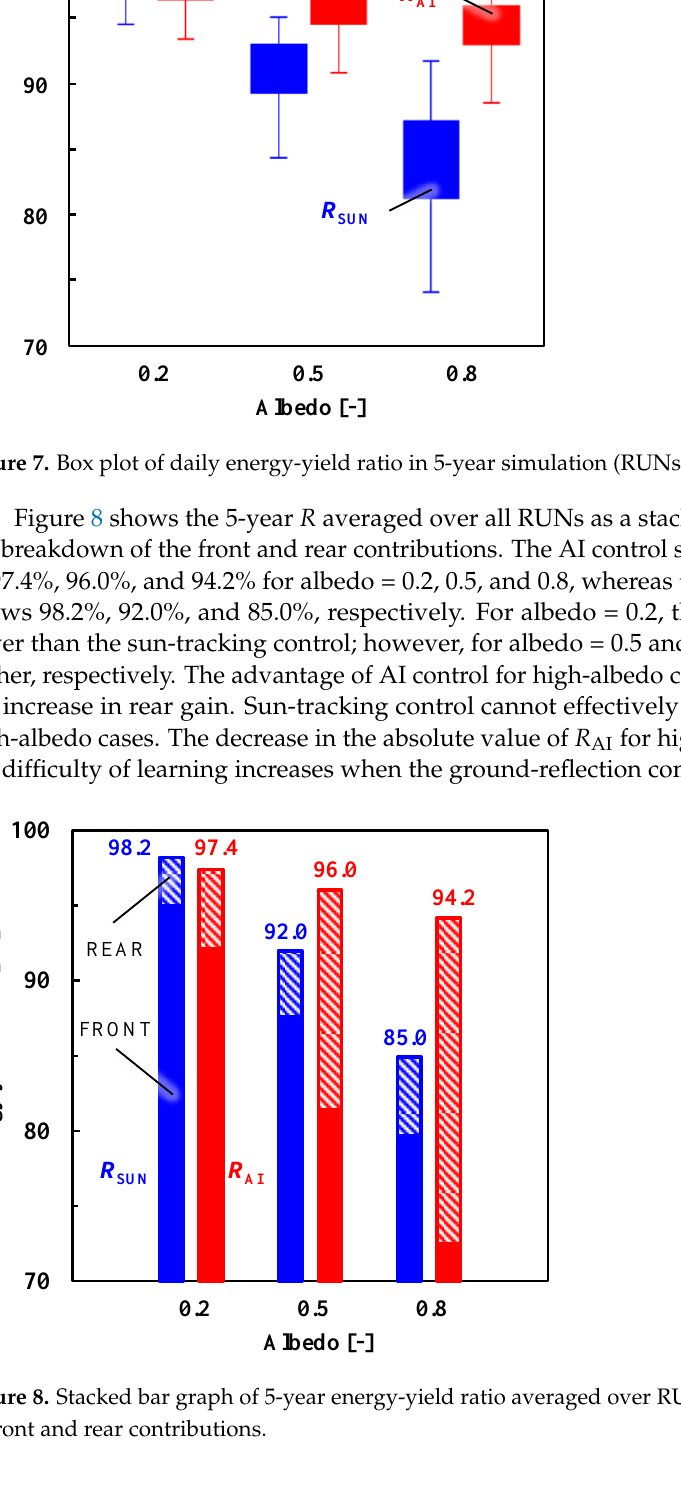
Figure 6. Variation of daily energy-yield ratio of AI control ( R AI ) over 100 learning days from the start of the 5-year simulation (RUNs 1 – 5).